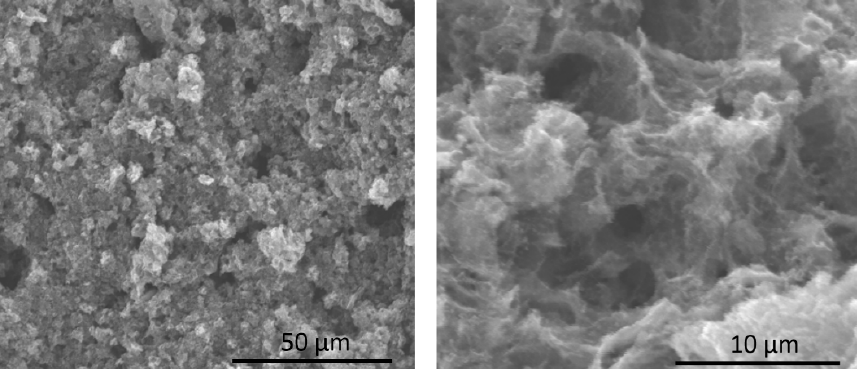
Figure 1. Scanning electron microscopy images of the Glu-NC-8Co catalyst material.